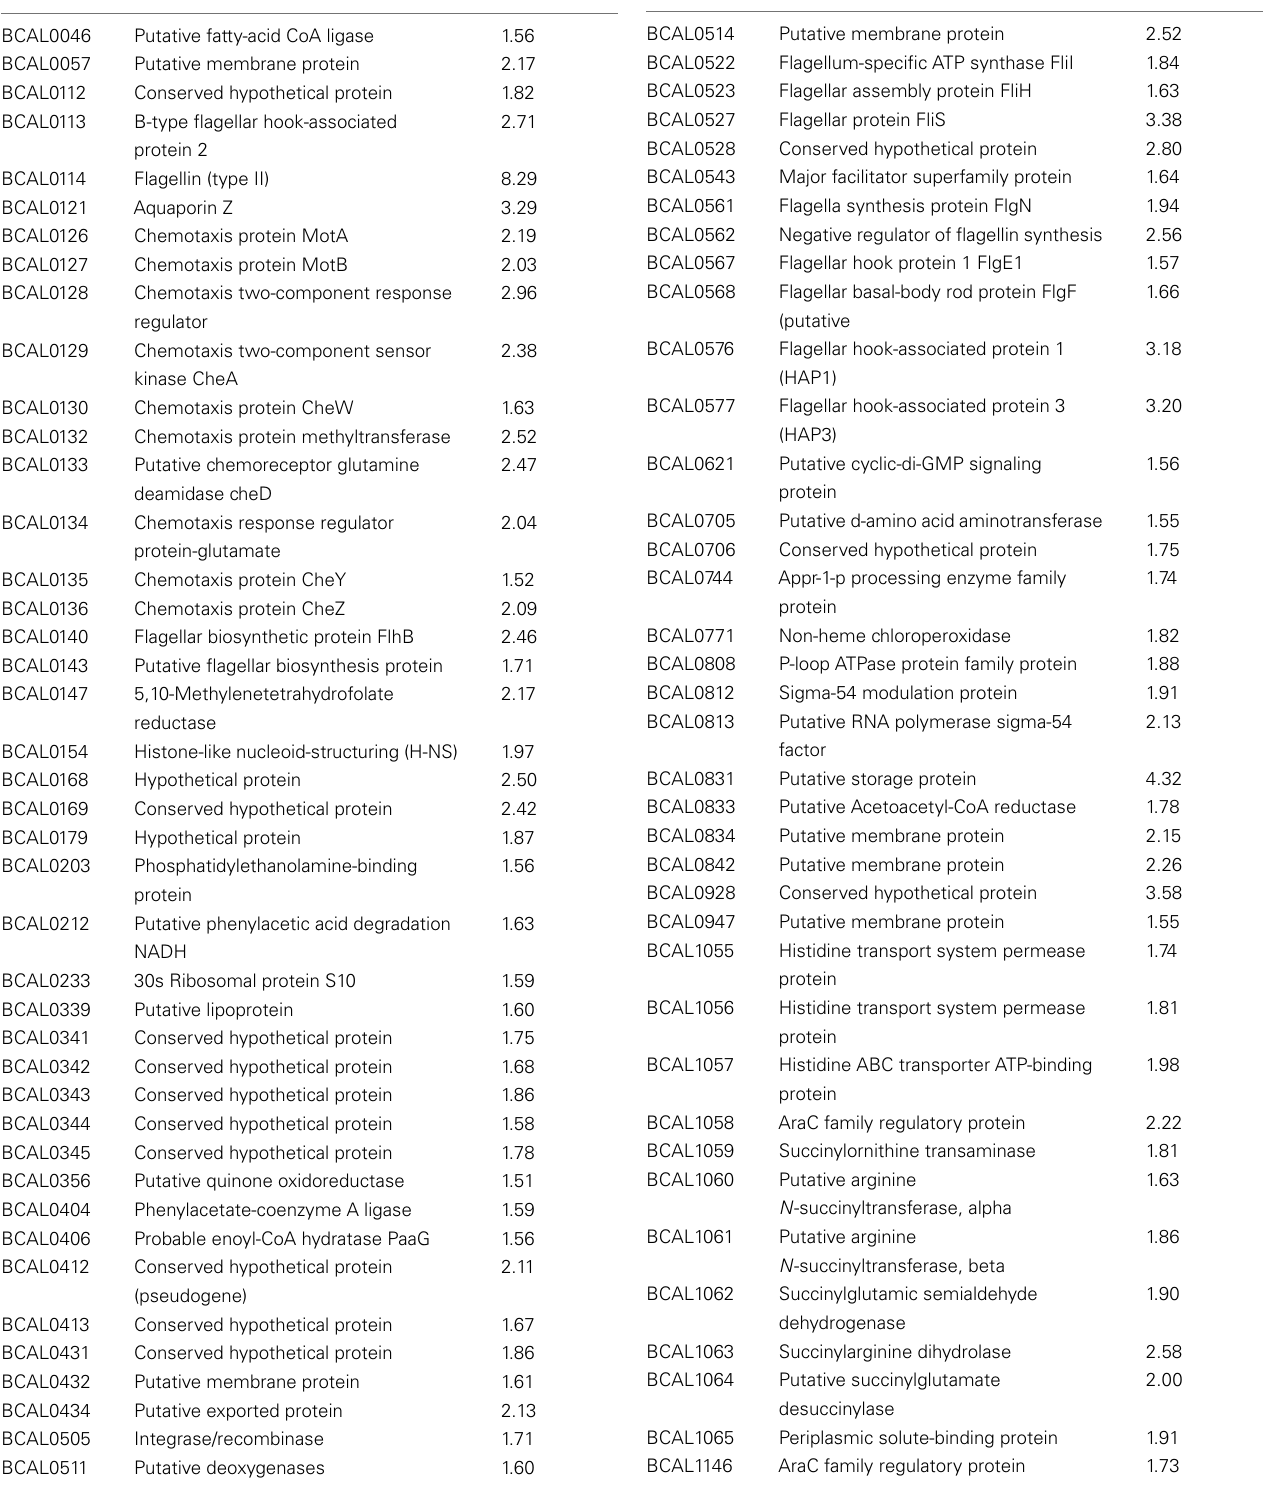
TableA2 | Burkholderia cenocepacia genes induced during culture in vitro